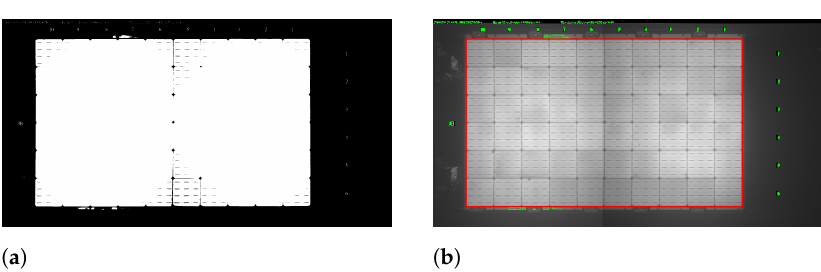
Figure 8. Contour tracing. ( a ) Thresholded EL image. ( b ) Target contour area for panel region extraction. Step 2: Horizontal and Vertical Lines